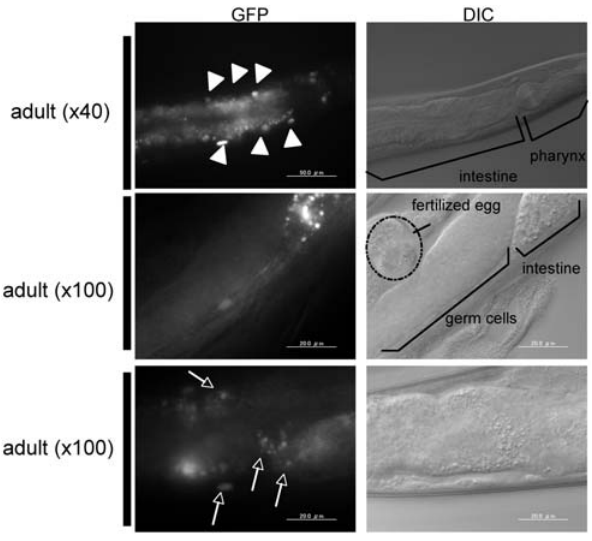
Figure 4. Pqbp-1.1-Venus fusion protein expression in adult nematode. Expression in the pharynx decreases. Intestinal cells keep a high expression level of pqbp-1.1-Venus in adult worms. Arrowheads indicate intestinal cells. Somatic gonads show no expression of pqbp- 1.1-Venus. In the tail region, fluorescence was detected in several neurons